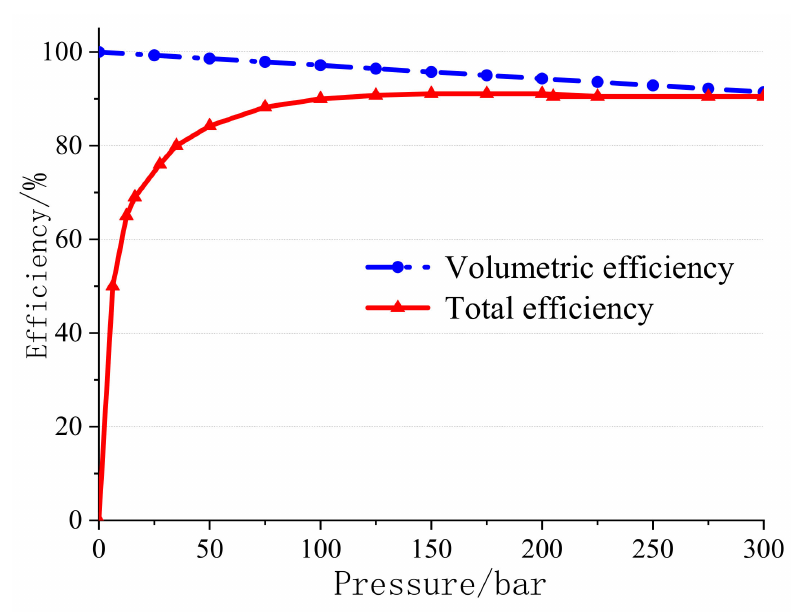
Figure 6. Efficiency curve of the internal gear pump.